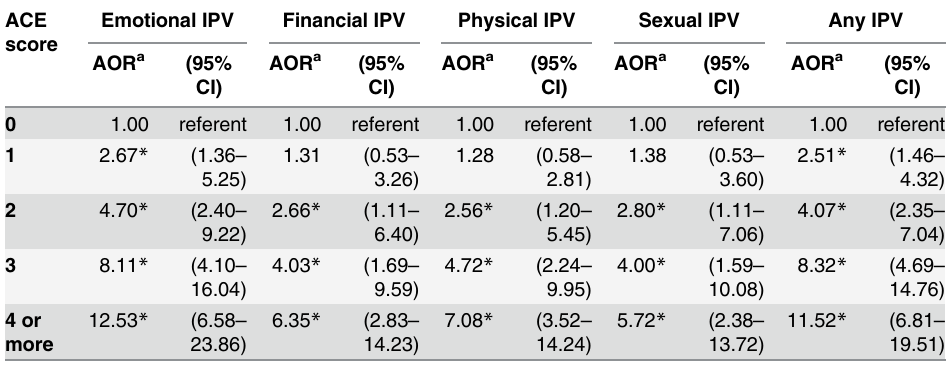
Table 6. Logistic regression analysis of the odds of intimate partner violence (IPV) perpetration with exposure to adverse childhood experiences (ACE) score among ever-partnered Sri Lankan men (n = 1252), UN Multi-Country Study on Men and Violence in Asia and the Pacific, Sri Lanka, 2011 –